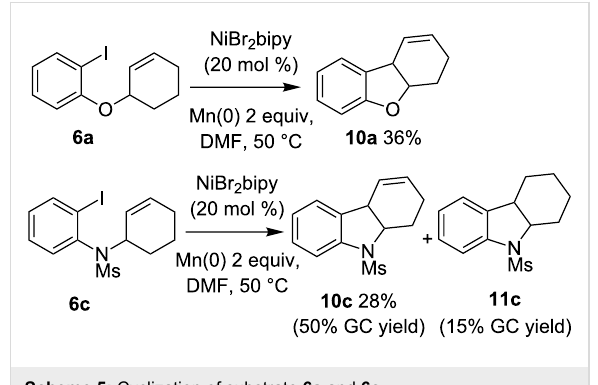
Scheme 5: Cyclization of substrate 6a and 6c